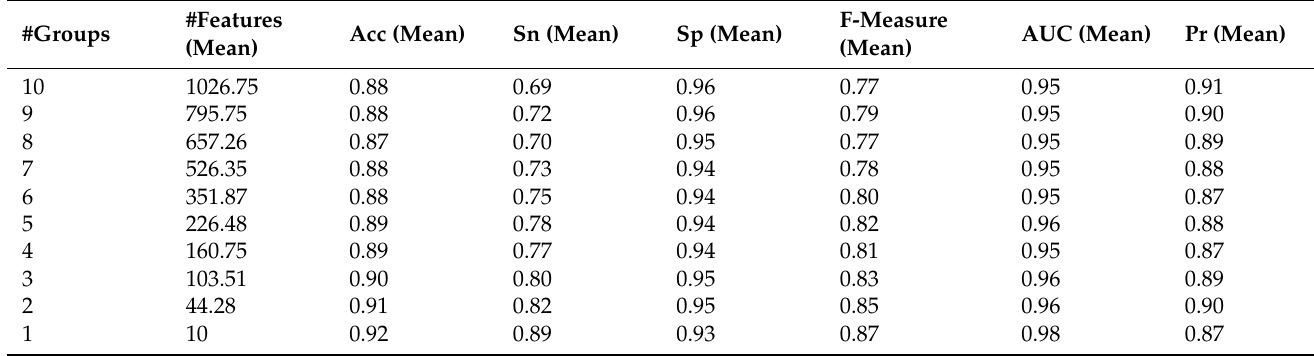
Table 3. Performance results of the AMP-GSM approach on the Gram-positive dataset of Dataset 1 (for 12 groups and 100-fold MCCV)